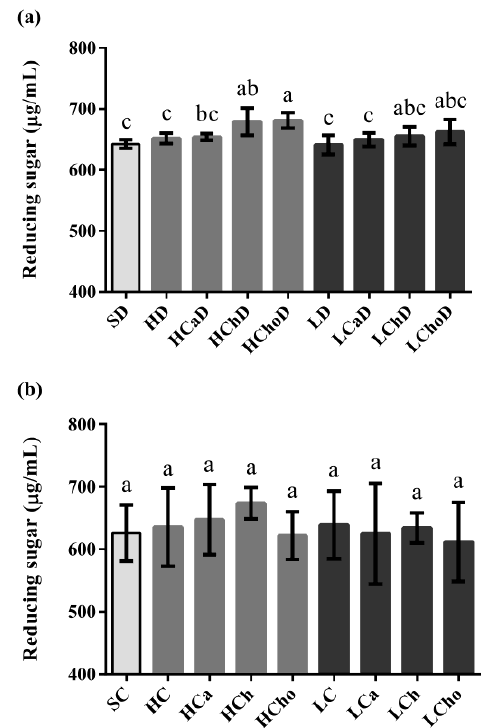
Figure Figure 3. Effect of calcium carbonate, chitosan, and chitooligosaccharide on reducing sugar concentration in brown sugar cookie dough ( a ) and cookies ( b ). a – c Indicate significant difference between different groups (n = 3; p < 0.05). SD: Sucrose dough; HD: High acrylamide level of brown